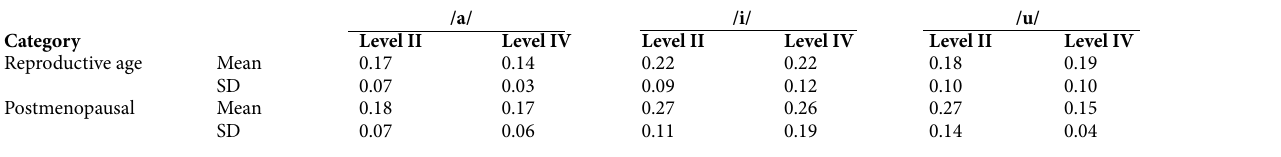
Table III. Means and SDs of NHR values for sustained phonation of /a/, /i/ and /u/ across the different groups